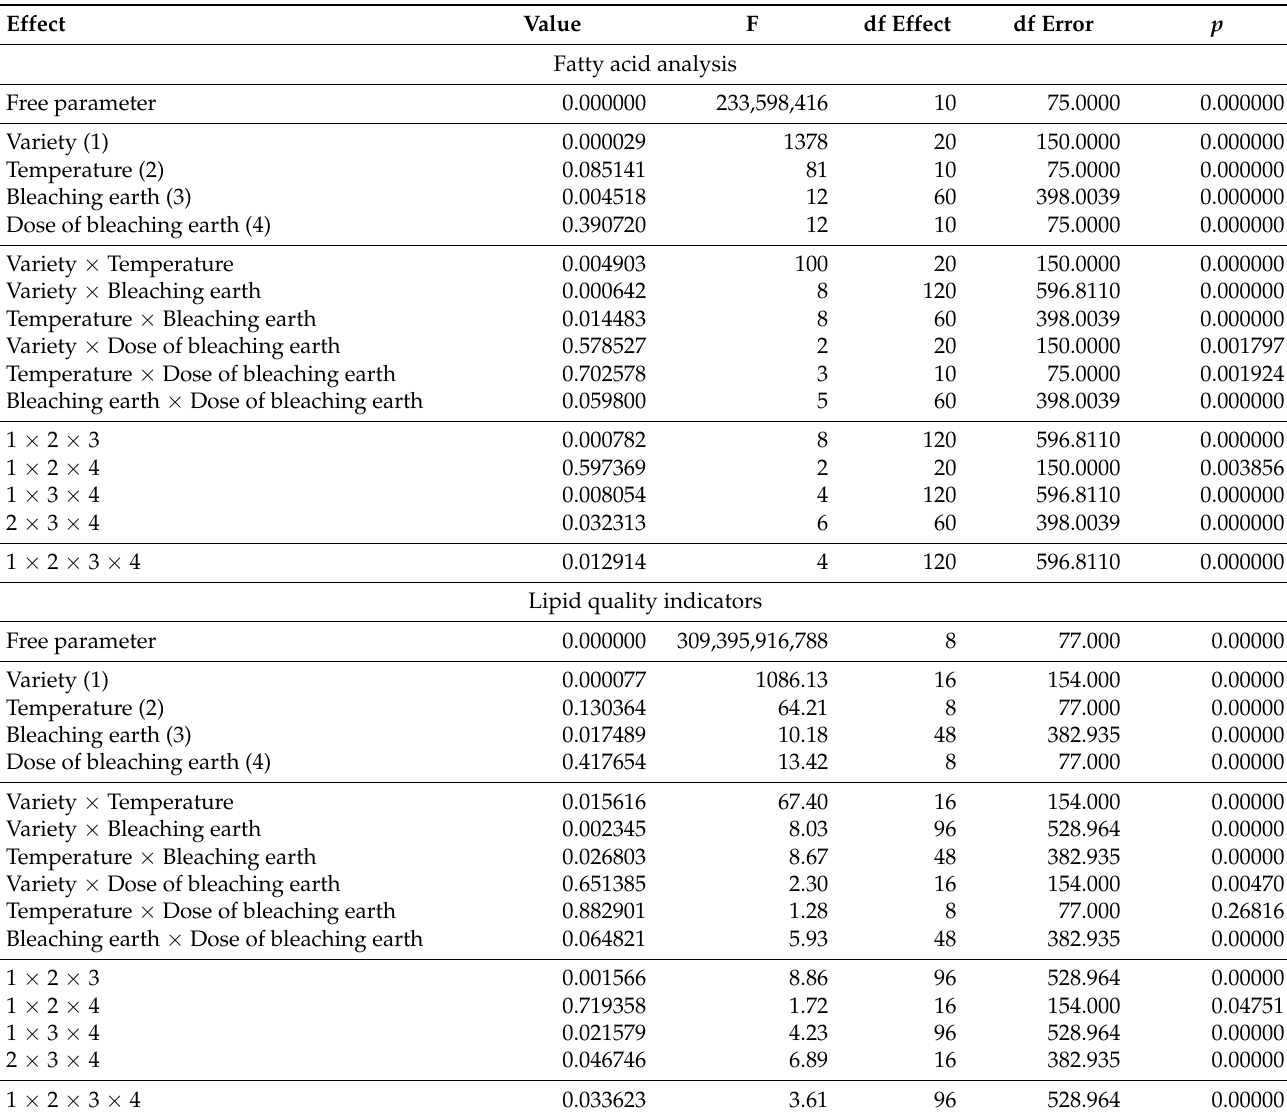
Table 1. The results of the MANOVA multivariate test for fatty acids analysis and lipid quality indicators (Wilks test; p <